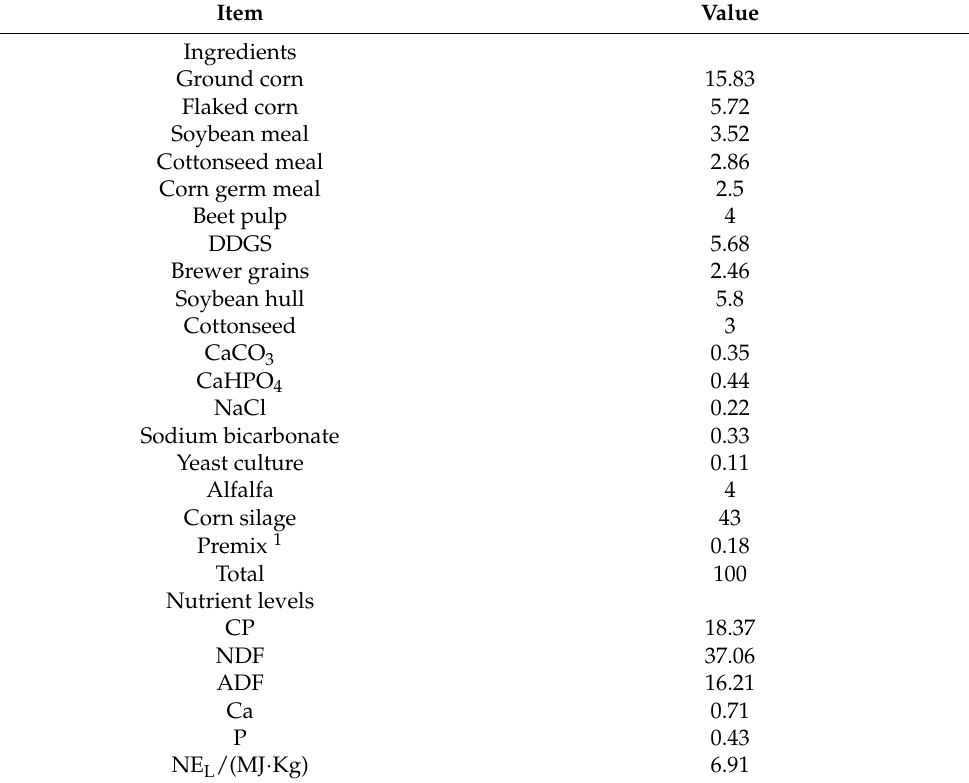
Table 1. Ingredients and chemical composition of the basal diet (%, as-fed DM).